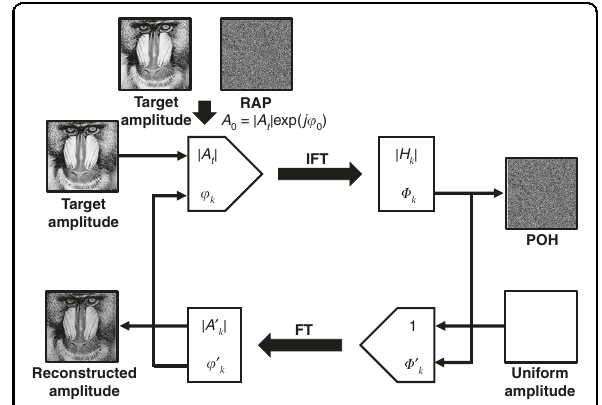
Fig. 4 Flowchart of GS